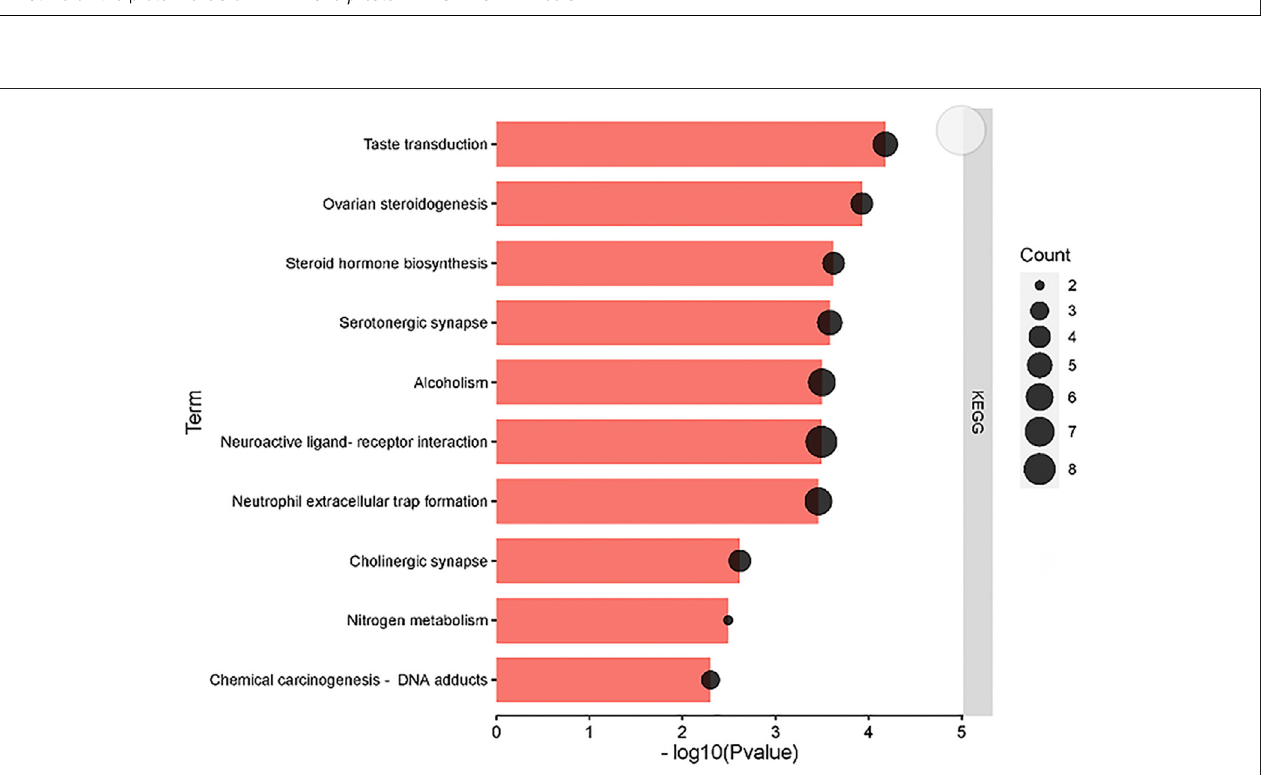
FIGURE 8 | KEGG pathway analysis of the core targets of the regulating metabolic networks of matrine.